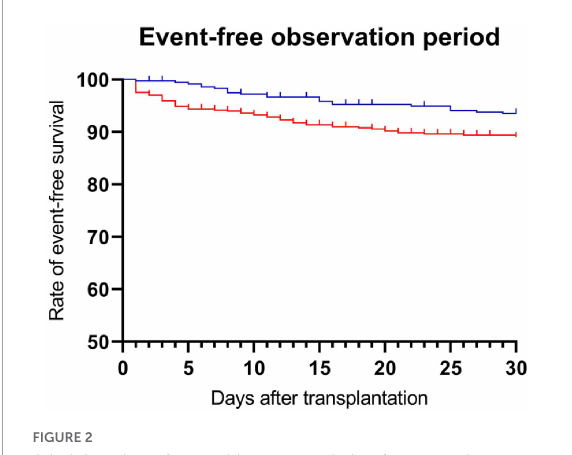
FIGURE2 Administration of recombinant coagulation factors and event-free survival. Patients were divided into no factor and factor groups. The p -value was evaluated using the log-rank test ( p = 0.01). (Blue), no factor group; (Red), factor